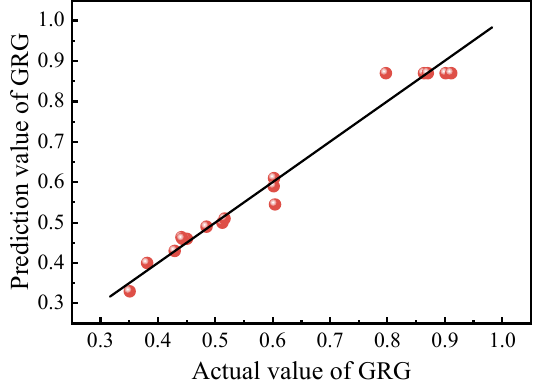
Figure 8. Comparison of actual and prediction values of GRG. To reflect the influence of the interaction of each factor on the GRG response value, Table 7. ANOVA results for response surface model of GRG. the three-dimensional response surface of GRG under the interaction of different factors was established using the mathematical prediction model, as shown in Figure 9. The shape of the response surface of the GRG model under the interaction of different factors is a quadratic paraboloid with a downward opening, indicating a maximum value of GRG in the test range. According to the variance analysis results of the GRG response model in Table 7, the influence of the three factors on the GRG model was in the order of B > A > C . The interaction of curing agent dosage A and accelerator dosage C had the most significant influence on GRG. The optimized GRG response surface model was analyzed using Design- Expert 8.0 software, and the optimal gray correlation degree was 0.885, corresponding to a curing agent dosage of 160.7%, toughening agent dosage of 16.1%, and accelerator dosage of 3.0%.